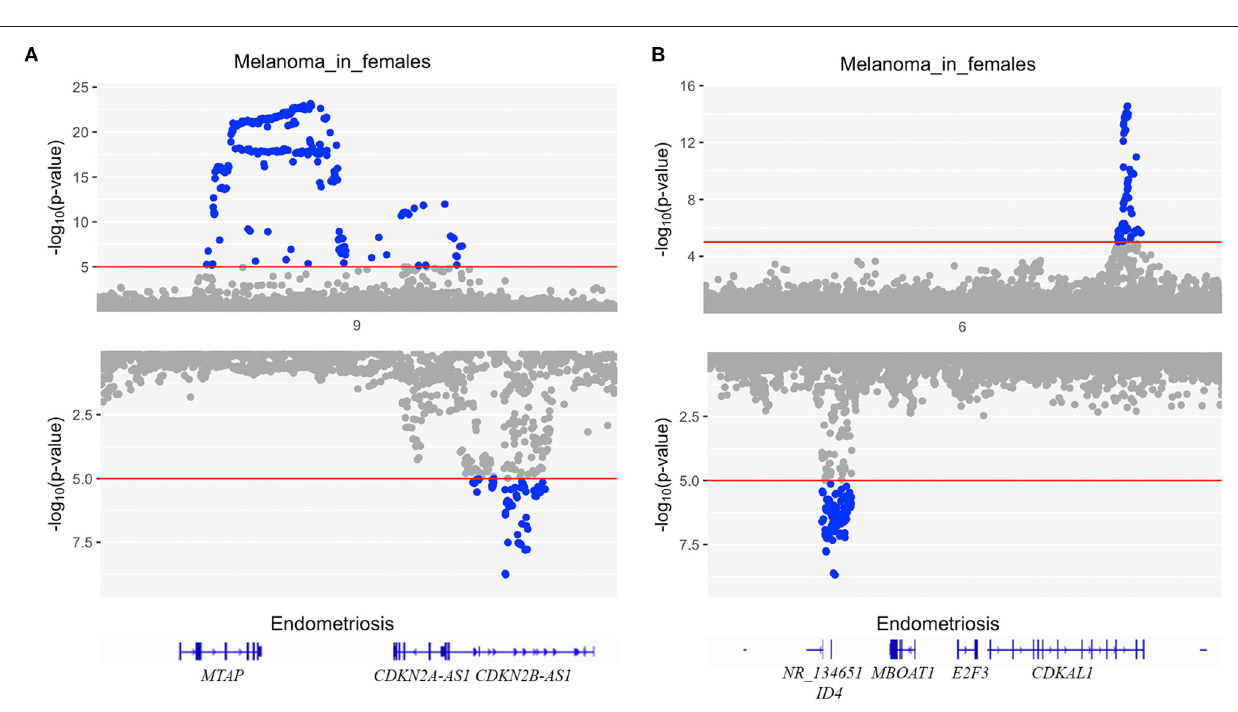
FIGURE 3 | Mirrored Manhattan plots for endometriosis (bottom) and melanoma in females (top) at two regions with the highest probability estimate for independent causal variants in the same risk locus (PPA_4) using GWAS-PW. (A) risk locus chr9:20464018-22205246 around CDKN2A and (B) risk locus chr6:19207758-21683982 around CDKAL1